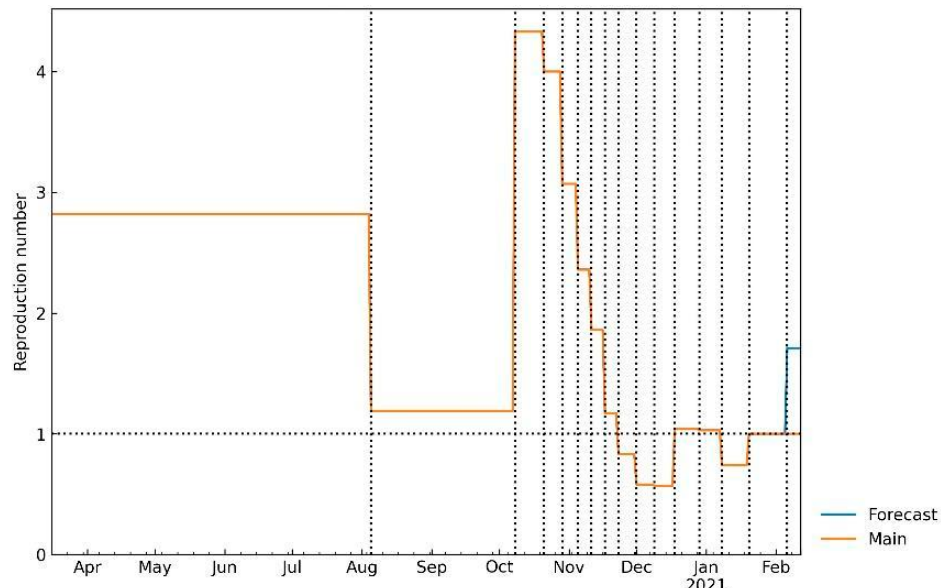
Figure 6. Poland COVID ‐ 19: reproduction number over time (as of 13 February 2021; results: CovsirPhy Python Application).